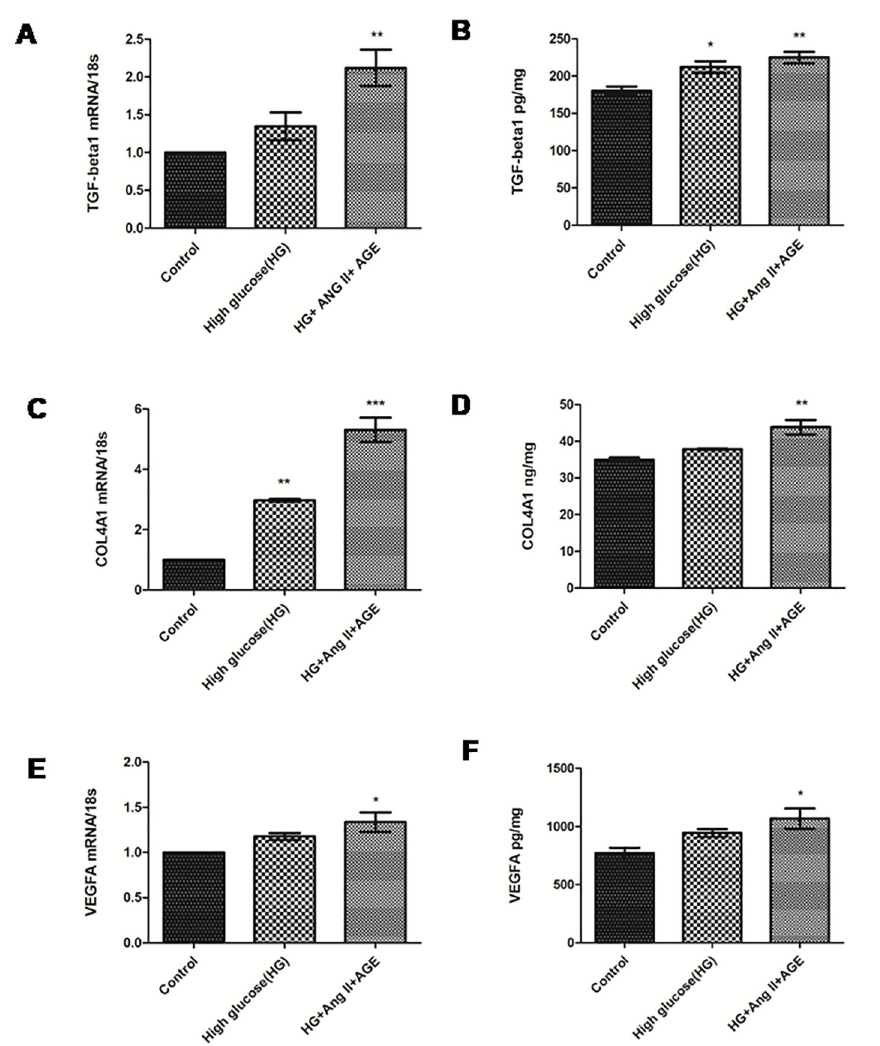
Fig 2. Effect of high glucose, angiotensin II and AGE on RPTECs. A and B: Assessment of mRNA expression profiles and protein levels of TGF- β 1 in control, HG and cells treated with HG (30 mM), Ang II (1 μ M) and AGE products (150 μ g/ml) respectively. C and D : Assessment of mRNA expression profiles and protein levels of VEGF-A in control and cells treated with HG (30 mM), Ang II (1 μ M) and AGE product (150 μ g/ml) respectively and E: Assessment of mRNA level and protein level of Col4A1 in control and cells treated with HG (30 mM), Ang II (1 μ M) and AGE product (150 μ g/ml) respectively. Results are represented as mean ± S.D. (n = 3) , � p < 0.05, �� p < 0.01, ��� p < 0.001 which shows significant difference in comparison with control